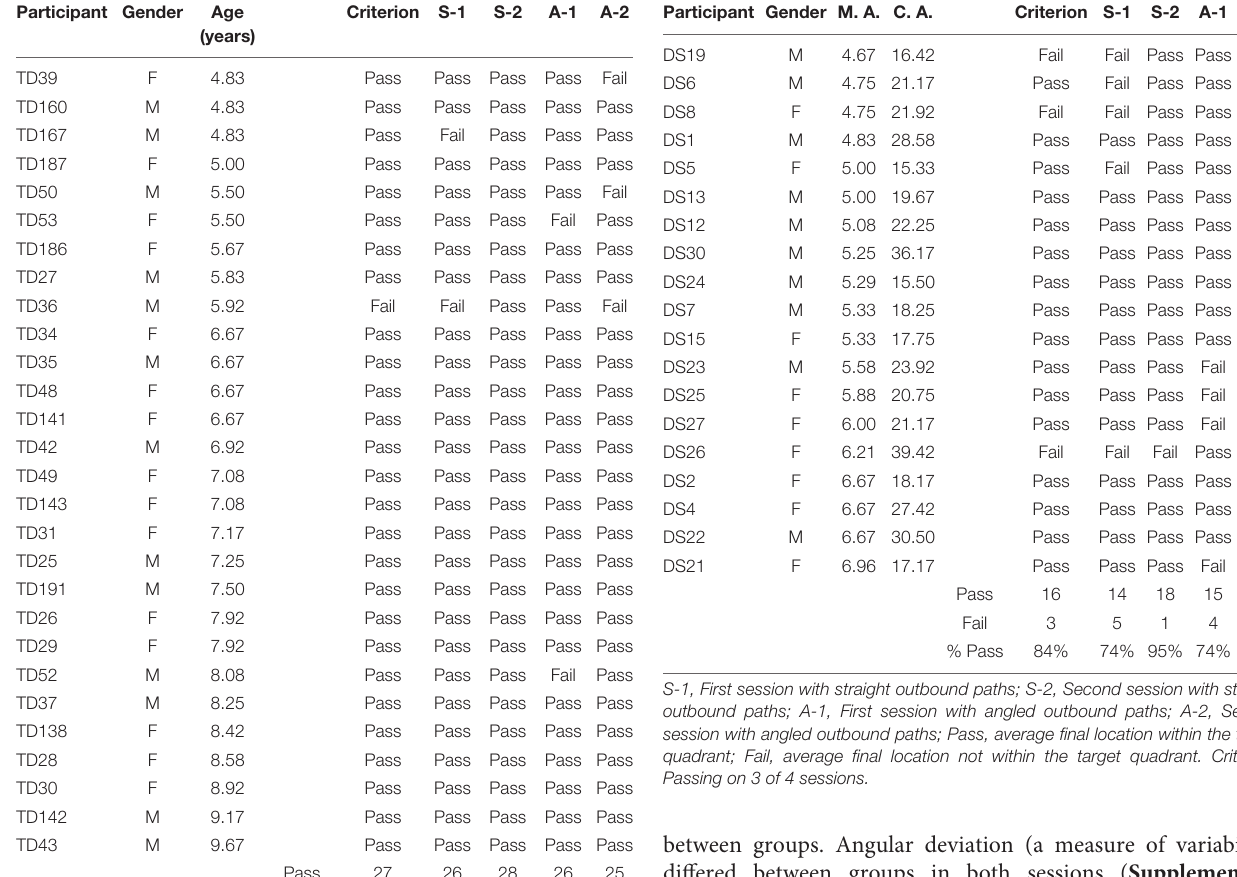
TABLE 2 | Individual performance of TD children in the homing task. Participant Gender Age Criterion S-1 (years)